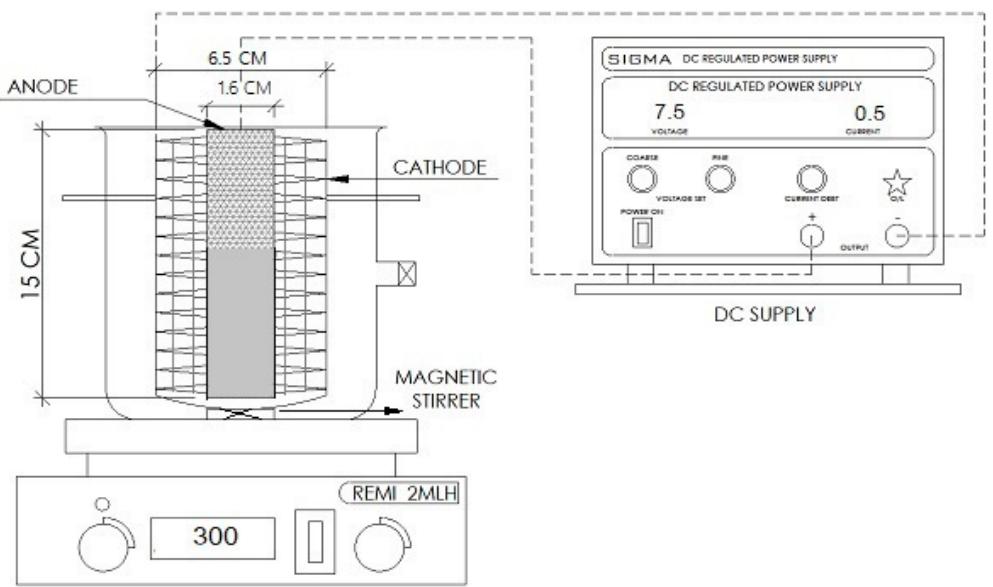
Figure 1. Schematic representation of experimental set up.